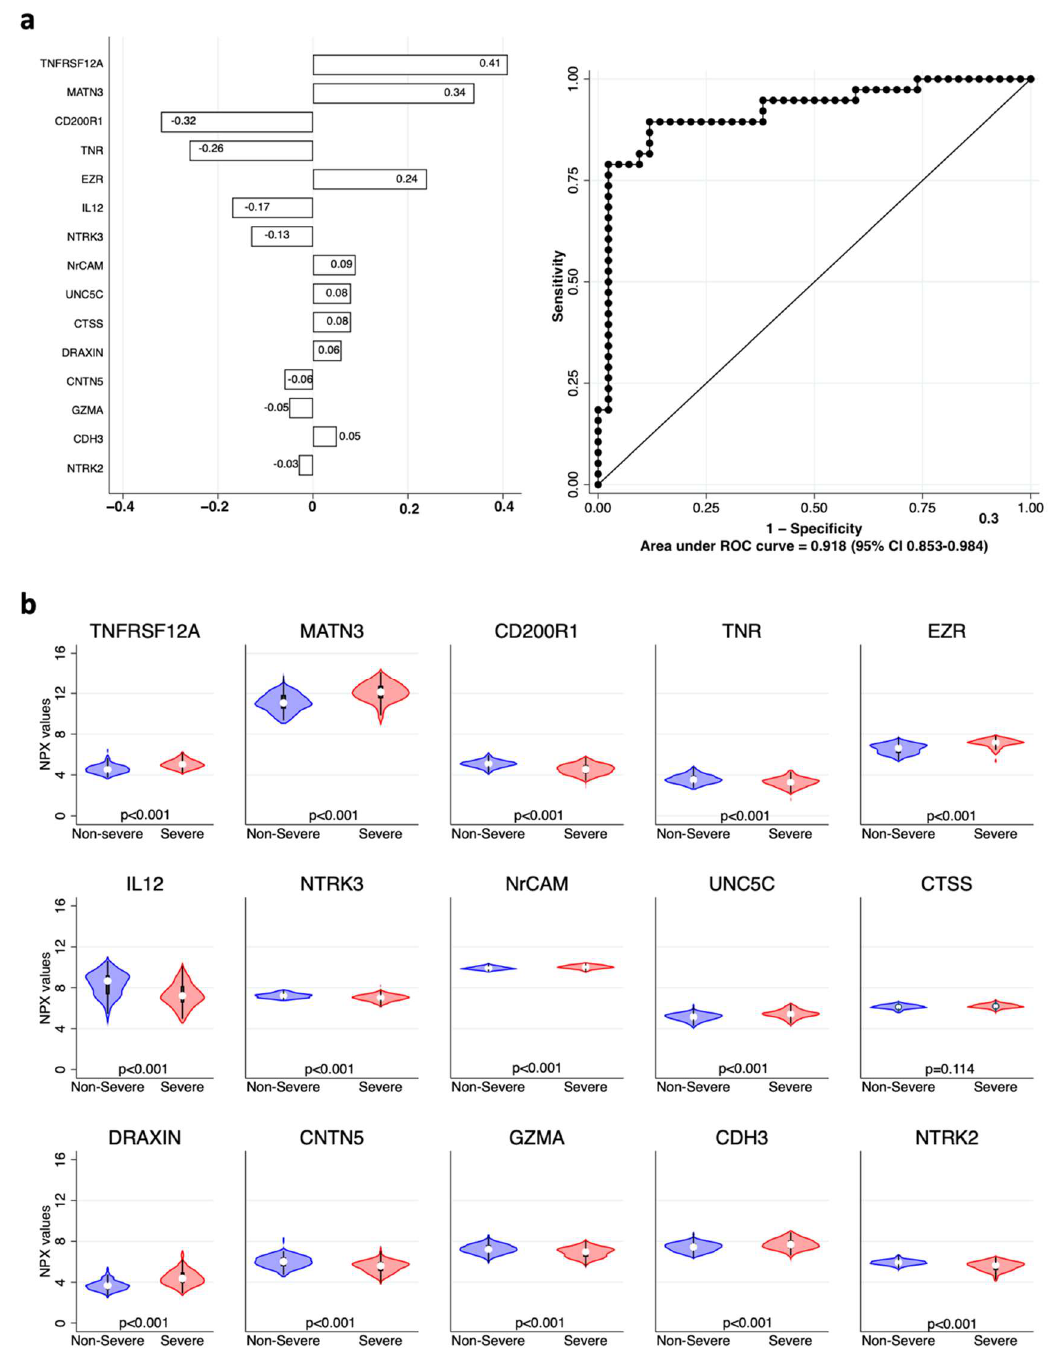
Figure 4. Neurology biomarkers associated with COVID-19 severity. ( a ) Elastic net logistic regression with neurology-related variables. Coefficients of each variable are shown in the left panel as horizontal bars. The right panel shows the ROC and AUC of 0.918 (95% CI 0.853–0.984). ( b ) Violin plots showing the distribution of the normalized protein expression (NPX) values of each variable included in the model in “non-severe” (blue) vs. “severe” (red) patients; p values for each comparison are shown at the bottom of each plot.